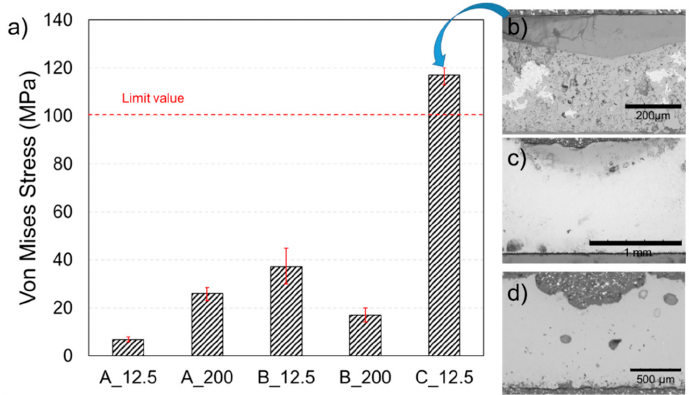
Figure 9. ( a ) Von Mises stress for the different process configuration (residual internal porosity and the amount of oxygen inside the coating lower the elastic limit of the bulk titanium ( ≈ 290